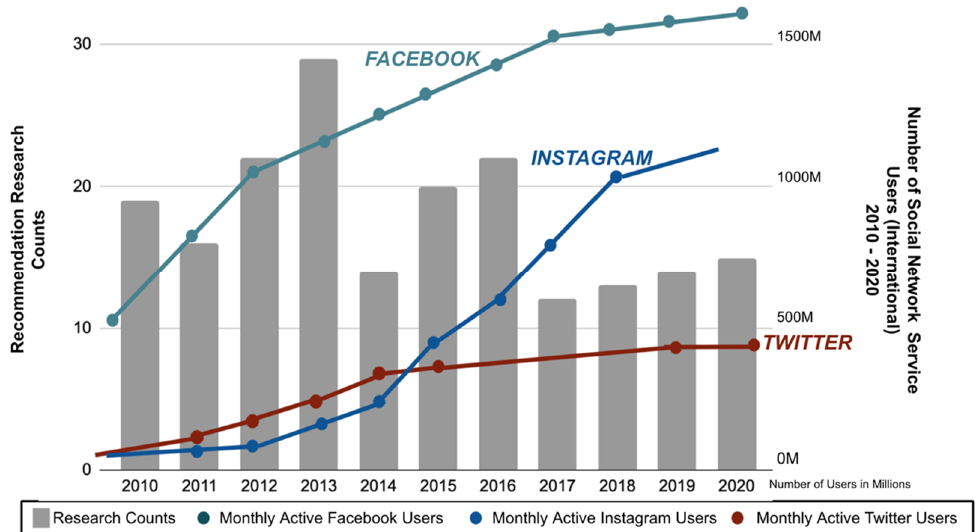
Figure 24. Social network service field research trend from 2010 to 2021 and the number of users of Facebook, Twitter, and Instagram, which are representative social network service types.